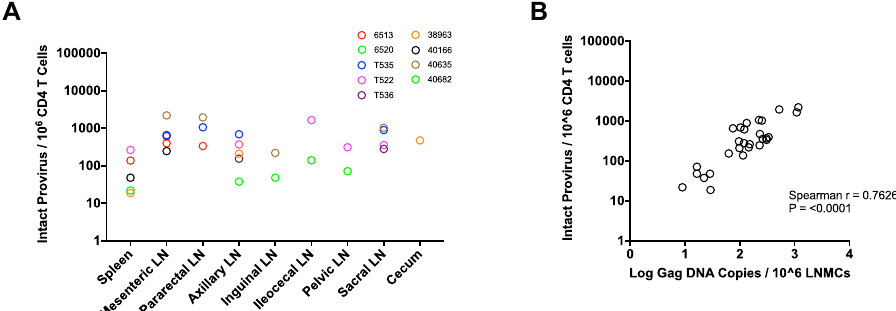
Fig. 4 Distribution of Intact Proviral sequences per 10 6 CD4 T cells in lymphoid tissues from animals in the Late ART and Early ART rhesus monkeys. A Tissue distribution of intact proviruses per 10 6 CD4 T cells from rhesus macaques in the Late and Early ART cohorts measured by the SIV Intact Proviral DNA Assay (IPDA). Each colored dot represents one animal. B Correlation between IPDA viruses measured in each lymphoid tissue selected in ( A ) and viral DNA gag copies per 10 6 lymph node mononuclear cells (LNMCs) (Fig.